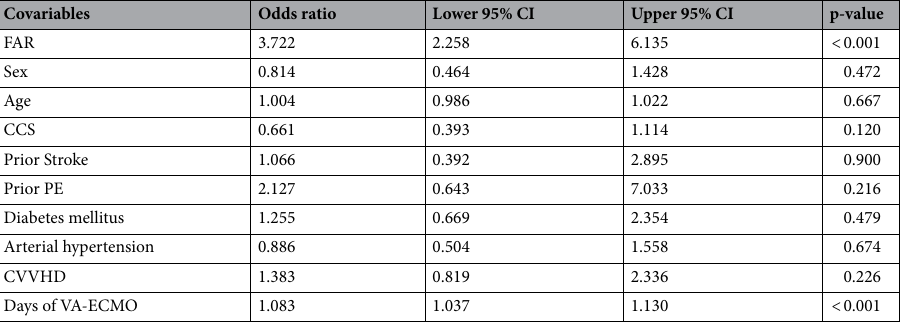
Covariables Odds ratio Lower 95% CI Upper 95%